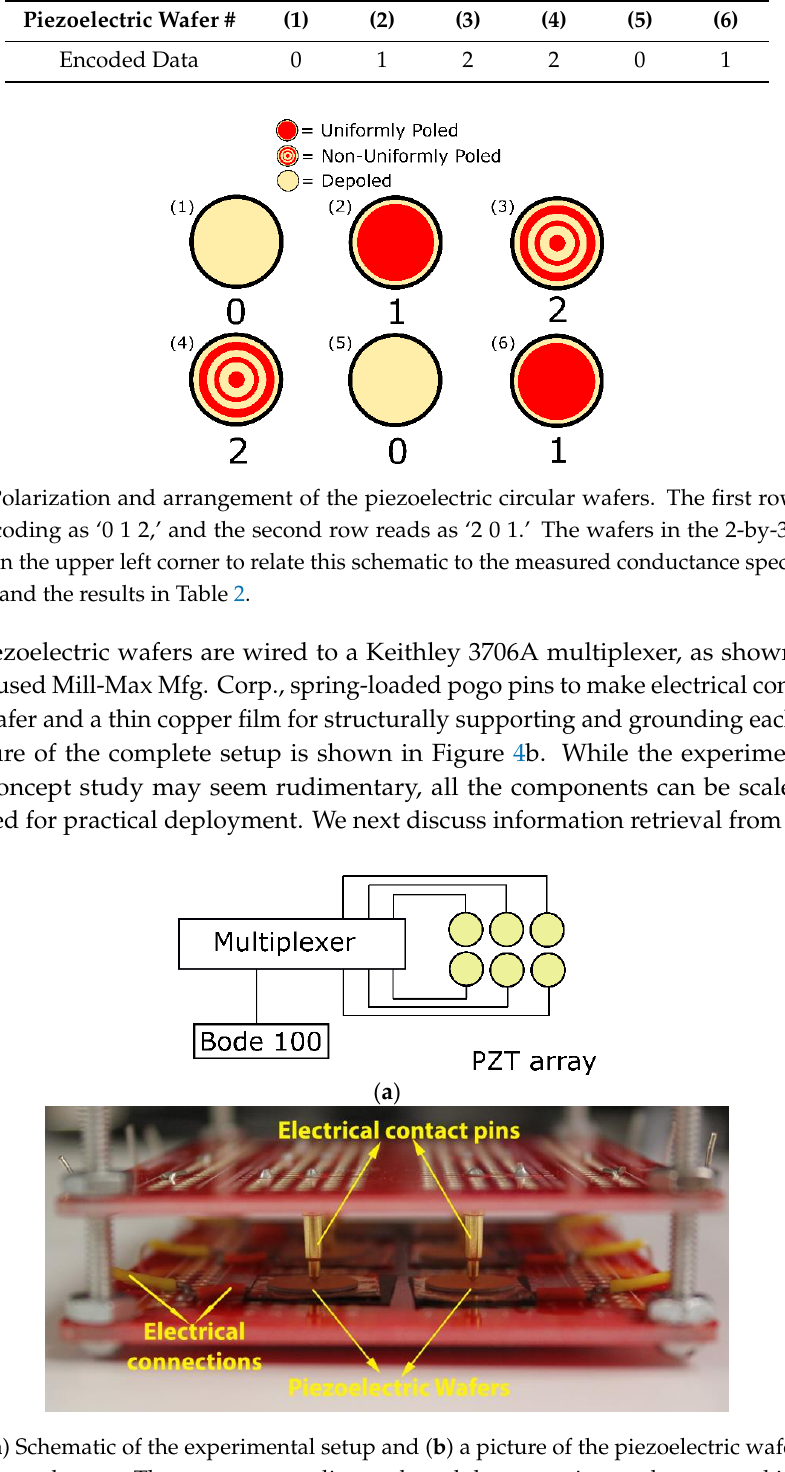
Figure 4. ( a ) Schematic of the experimental setup and ( b ) a picture of the piezoelectric wafer array in the experimental setup. The copper grounding pads and the pogo pins can be seen making contact with the piezoelectric circular wafers.